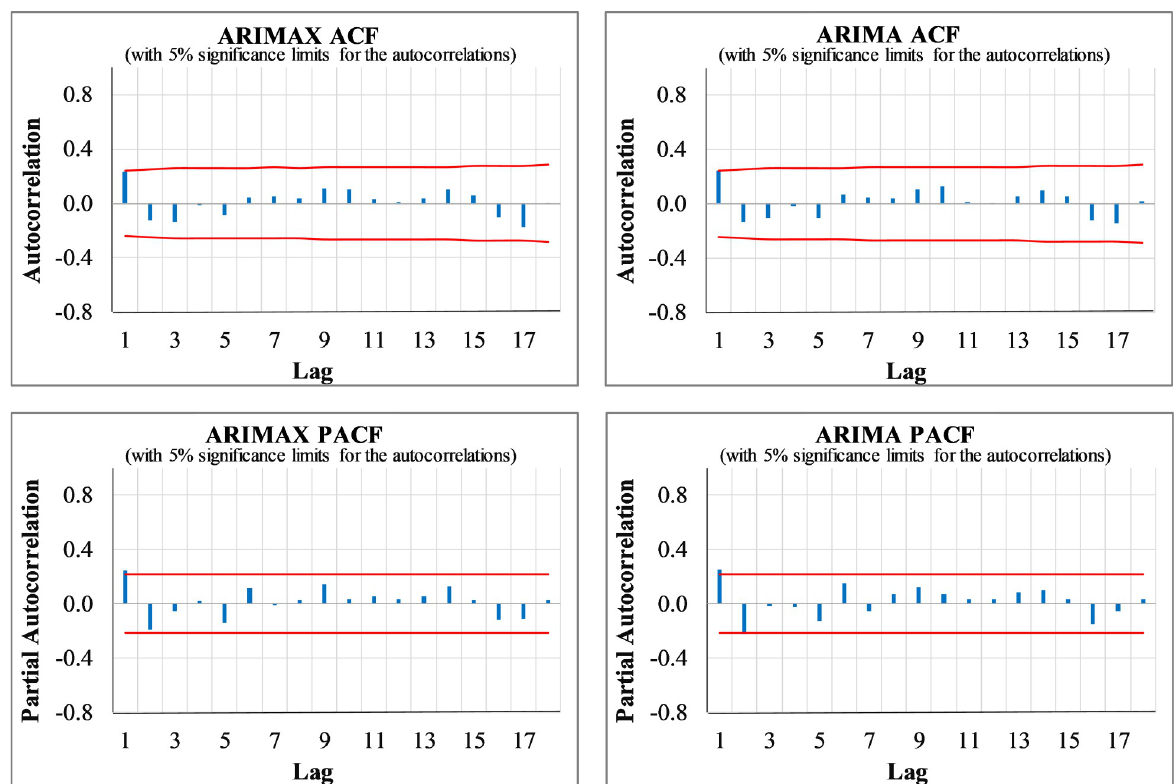
Fig 7. The residuals ACF/PACF of ARIMA and ARIMAX models (new weekly COVID cases).